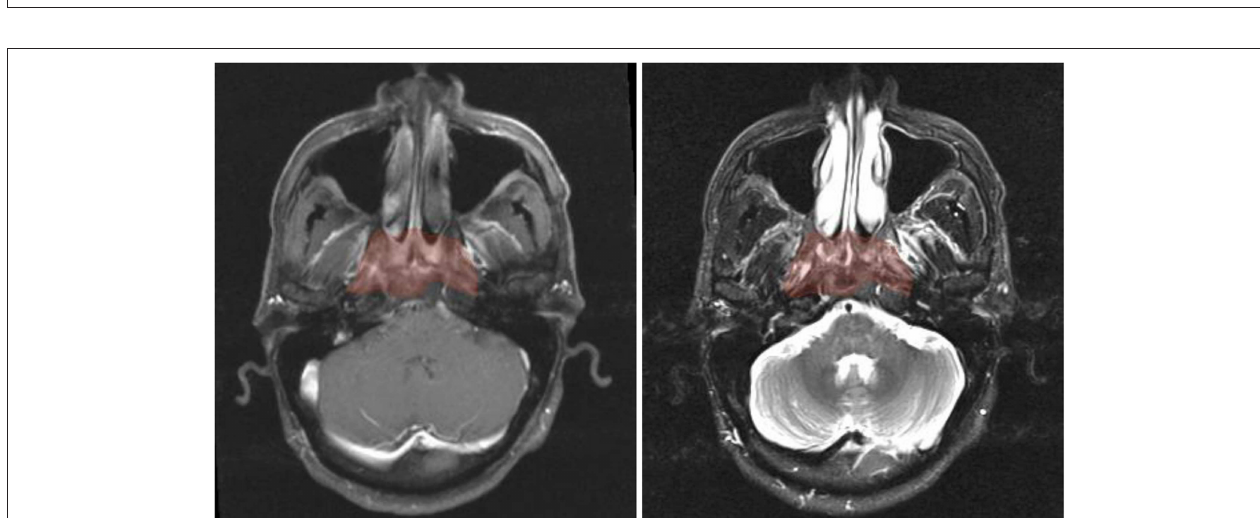
FIGURE 3 | Axial pre-treatment morphological MR images of a 44-year-old man with undifferentiated carcinoma of NPC (T3N2M0). Features of radiomics were extracted from the primary tumor area -GTVnp (red overlay). From left to right: CET1-w and T2-w MR image, respectively.